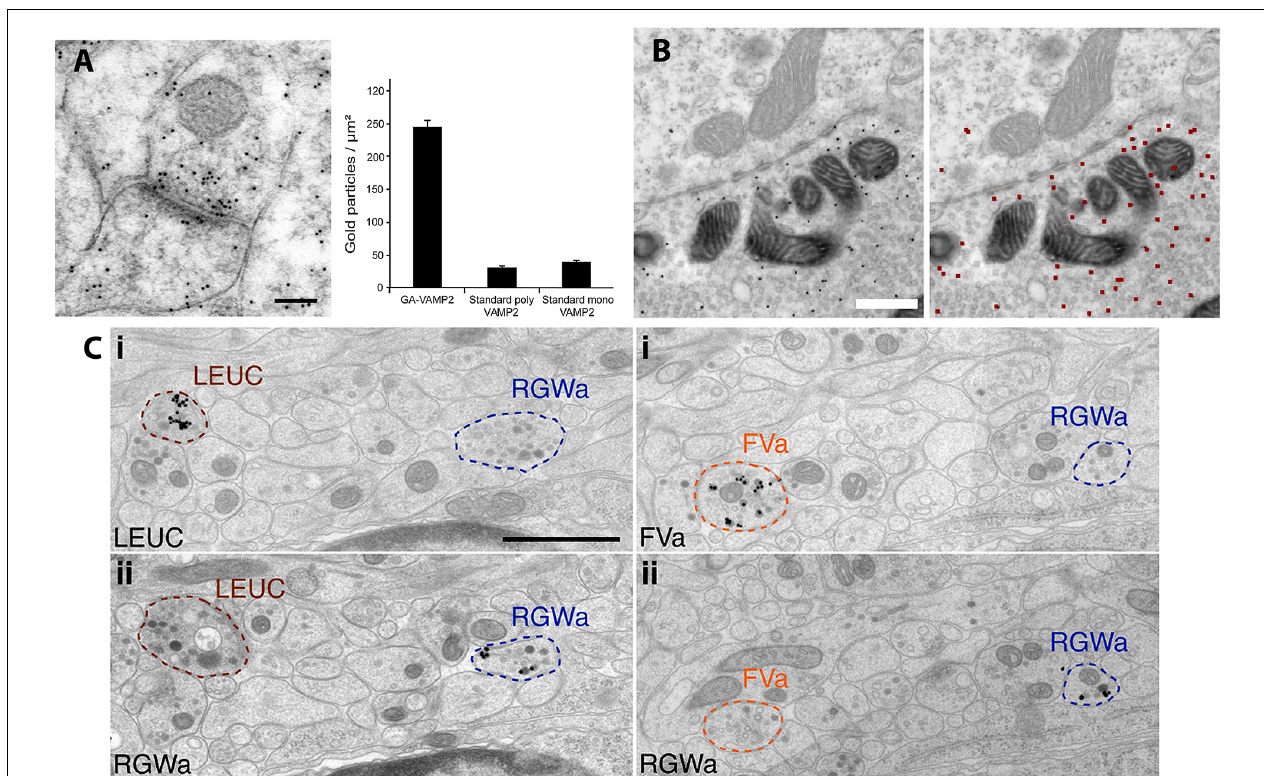
FIGURE 2 | Examples of variation in PIL protocols. (A) PIL of the synaptic protein, VAMP2, in the CA1 region of the rat hippocampus is significantly enhanced when the antibody is raised against a glutaraldehyde-fixed antigen (polyclonal; GA-VAMP2; image shown), compared to standard polyclonal and monoclonal VAMP2 antibodies. The scale bar is 100 nm. From Figure 4 of Hussain et al. (2019; open access). (B) PIL for GFP in calyx synapses in the medial nucleus of the trapezoid body, following injection of an EGFP-tracer compound. Gold particles are evident in the presynaptic terminal in the left image; the right image shows the annotated output of identified gold particles (colored red), as determined by the deep learning-based software tool, “Gold Digger.” The scale bar is 500 nm. From Figure 5 of Jerez et al. (2021; open access—http://creativecommons.org/licenses/by/4.0/). (C) PIL labeling with neuropeptide antibodies of axons from neural tissue in the larval marine annelid worm, Platynereis , embedded in epon and labeled with silver-enhanced, 0.8 nm gold. Neurite-specific labeling is demonstrated in serial sections seven sections apart, using the neuropeptides, leucokinin (LEUC), RGWamide (RGWa), and FVamide (FVa). The scale bar is 1 µ m. From Figure 2 of Shahidi et al. (2015; Creative commons attribution